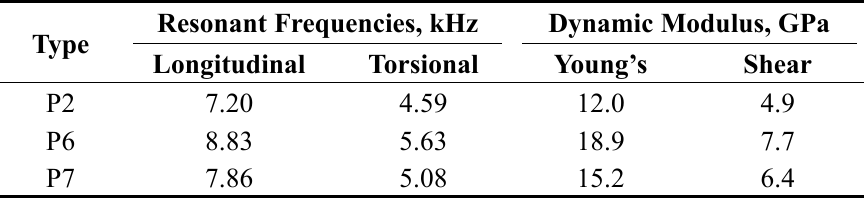
Table 4. Dynamic modulus of lightweight concrete at 28 days.